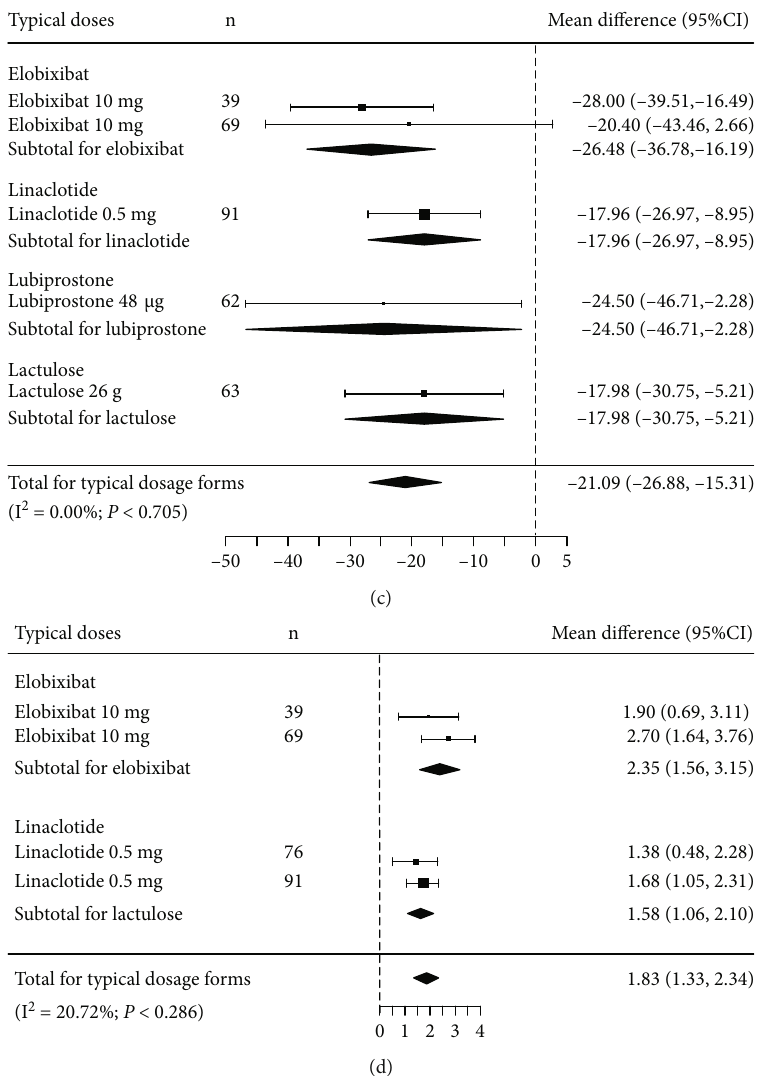
Figure 4: Forrest plot of random-e ff ects meta-analysis results: (a) change in weekly SBMs compared between typical doses; (b) proportion of patients with SBM within 24 hours compared between typical doses; (c) time to fi rst SBMs compared between typical doses; (d) change in weekly CSBMs compared between all doses. CSBM: complete spontaneous bowel movement; SBM: spontaneous bowel